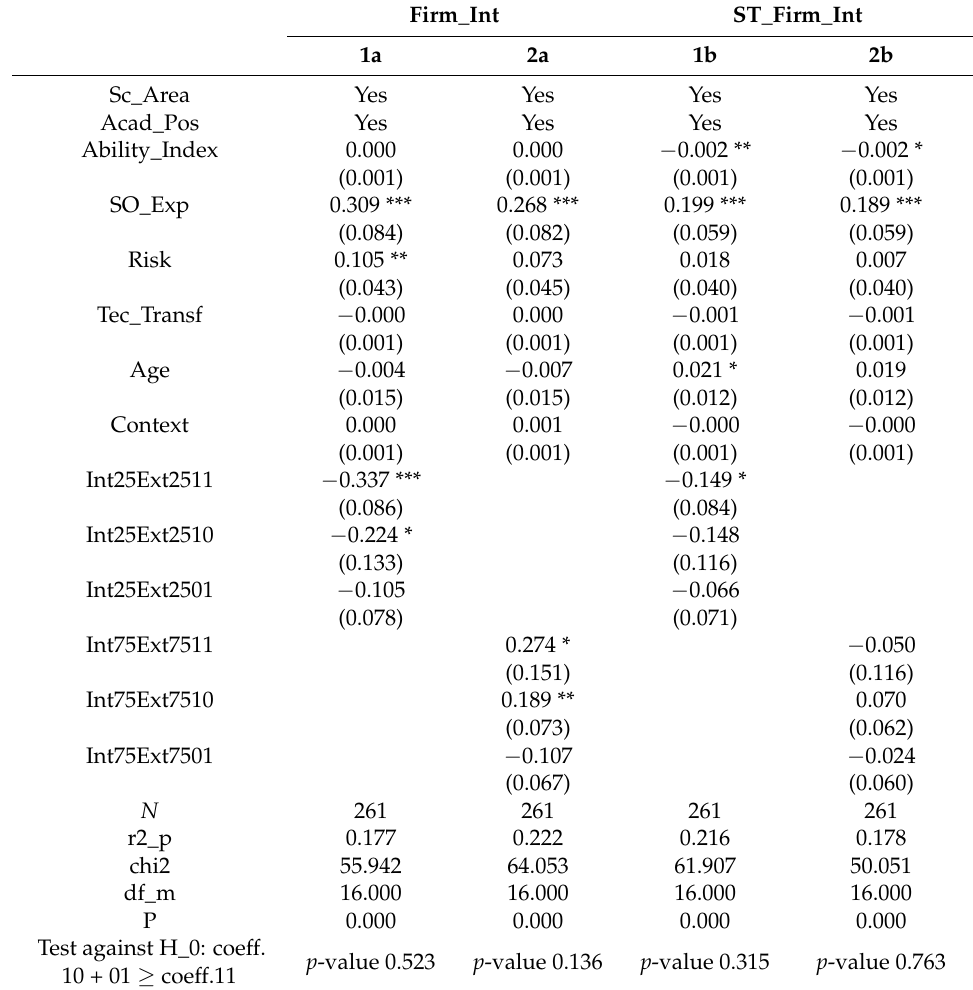
Table 11. Probit results (Marginal effects reported): Complementarity